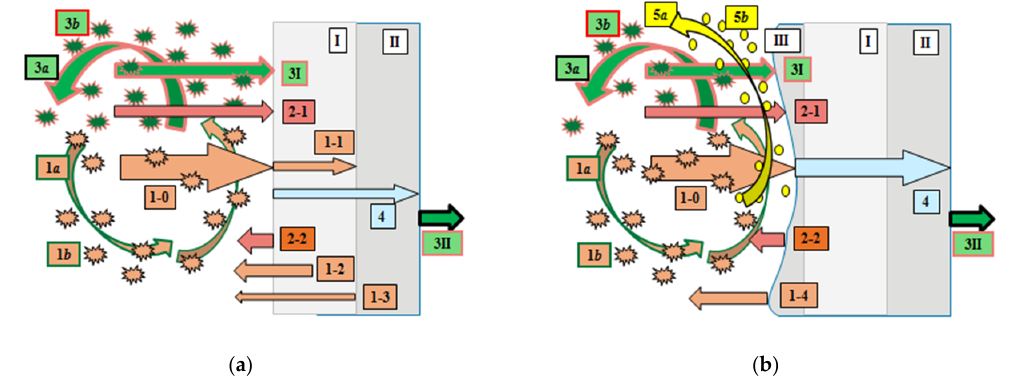
Figure 1. Radiant heat transfer for the model of coated CC walls (or fully made of ceramics) with volumetric ( a ) and surface ( b ) reflection under the following fluxes: short wavelength